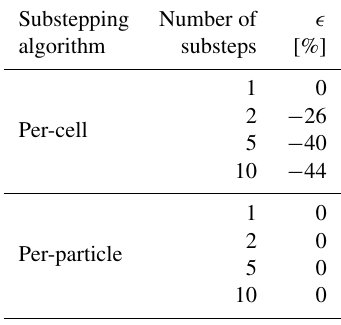
Table B1. Errors caused by substepping in the 1-D simula- tion of cloud edge advection. The error is defined as (cid:15) = (cid:16) (cid:17) − q exp q sim /q exp , where q l is the liquid water mixing ratio di- l l l agnosed at the end of the simulation from the cell to which cloud droplets were advected, i.e., the cell that was initially subsaturated. The superscripts “sim” and “exp” denote the simulated and ex- pected values,